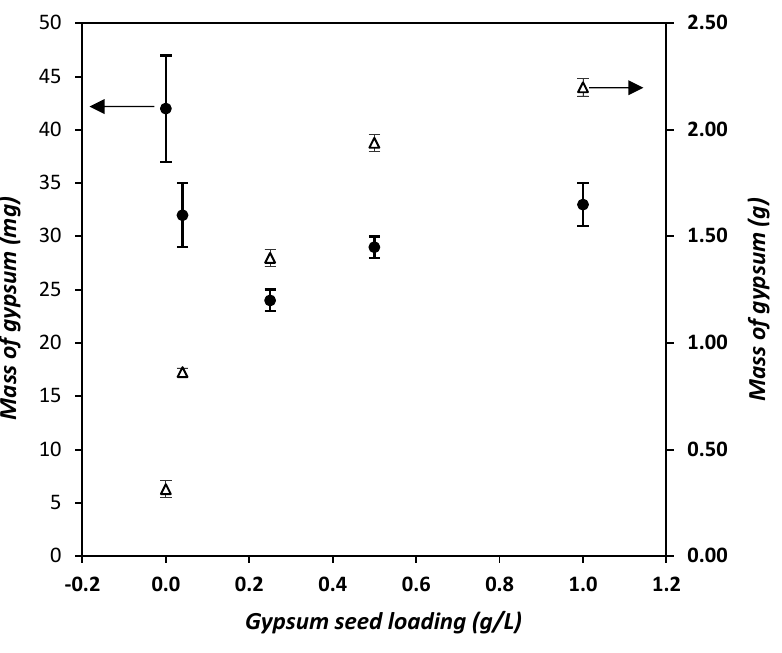
Figure 8. Seed loading against mass of gypsum scale deposited on the tube and mass of gypsum crystallized in the bulk solution.